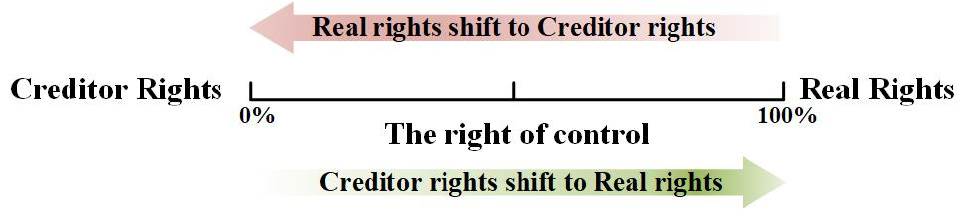
Figure 1. The right of control of the right holder.